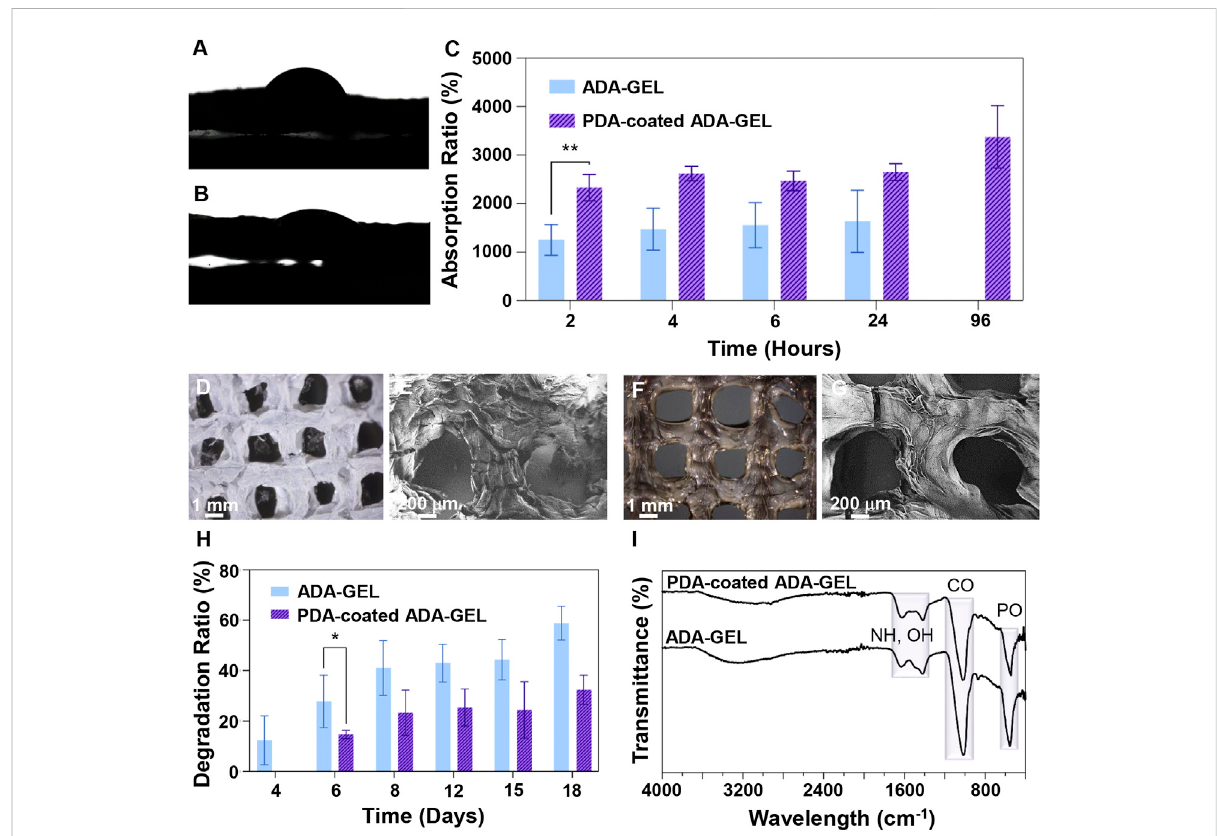
FIGURE 4 Interaction of scaffolds with biological-like fl uids. (A,B) Contact angle measurements of (A) ADA-GEL and (B) PDA-coated ADA-GEL scaffolds. (C) Absorption ratio of ADA-GEL and PDA-coated ADA-GEL scaffolds over time (2, 4, 6, 24, and 96 h). (D,F) Light microscope images and (E,G) FE- SEMimageof (D,E) ADA-GELand (F,G) PDA-coatedADA-GELscaffoldsaftera18-daysimmersioninmedium. (H) Degradation ratioofADA-GELand PDA-coatedADA-GELscaffoldsovertime(4,6,8,12,15,and18 days). (I) FTIRspectrumofADA-GELandPDA-coatedADA-GEL